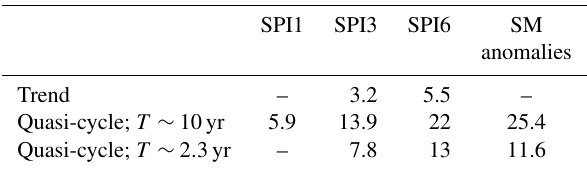
Table 1. Percentage of variance explained by the dominant modes of interannual variability detected, using SSA, with a window length of 120 months. Computations were done over SPI1, SPI3, SPI6, and soil moisture anomalies from January 1979 to Decem- ber 2018 in the core crop region. SPI1 SPI3 SPI6 SM anomalies Trend – 3.2 5.5 – Quasi-cycle; T ∼ 10yr 5.9 13.9 22 25.4 Quasi-cycle; T ∼ 2 .